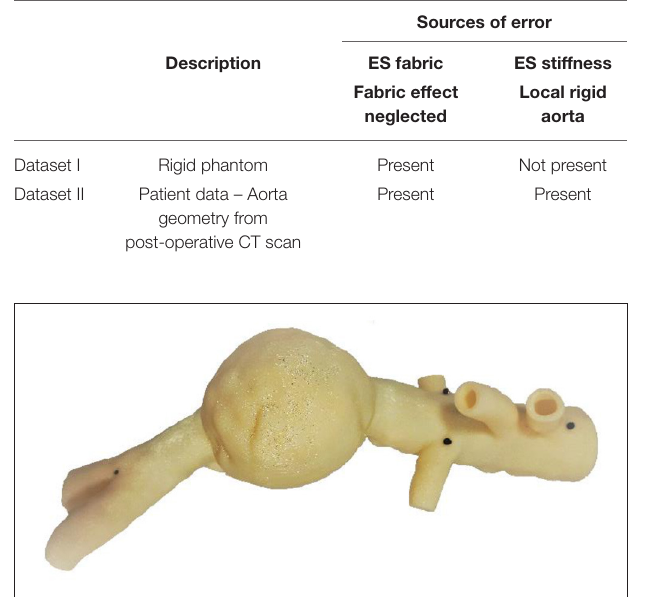
FIGURE 3 | 3D printed rigid phantom of an aorta for the validation of our simulations.